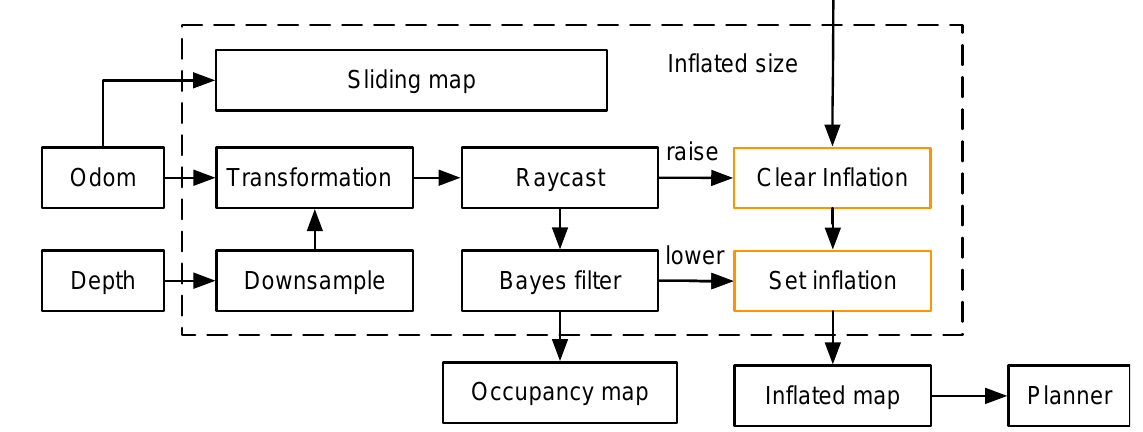
Figure 1. Schematic diagram of FIImap